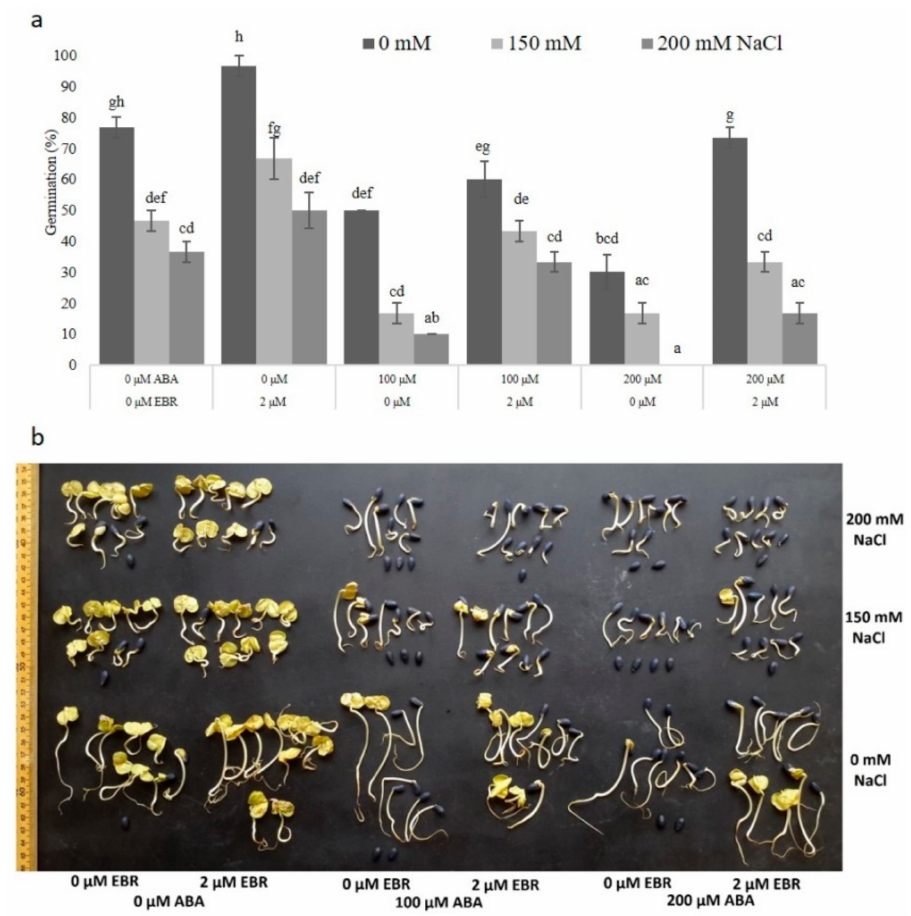
Figure 3. Cotton seed germination and seedling growth under salt stress following pre-treatment with EBR or ABA alone or together. Percent germination ( a ) and seedling phenotypes ( b ) in response to pre-treatment with EBR (0 and 2 µ M), ABA (100 and 200 µ M), and ABA + EBR (as indicated in figures) under 0, 150 and 200 mM NaCl were noted on the 4th and 13th day, respectively. Error bars represent standard error (SE) of the mean for three replicates ( n = 30). Different letters above the bars indicate significant differences in two-way ANOVA ( p < 0.05) followed by Tukey’s post hoc test. Similar to Sicala V-2, EBR enhanced cotyledon opening in Sicot 730, while ABA at 200 µ M completely inhibited cotyledon opening under all conditions (Figures 3b and